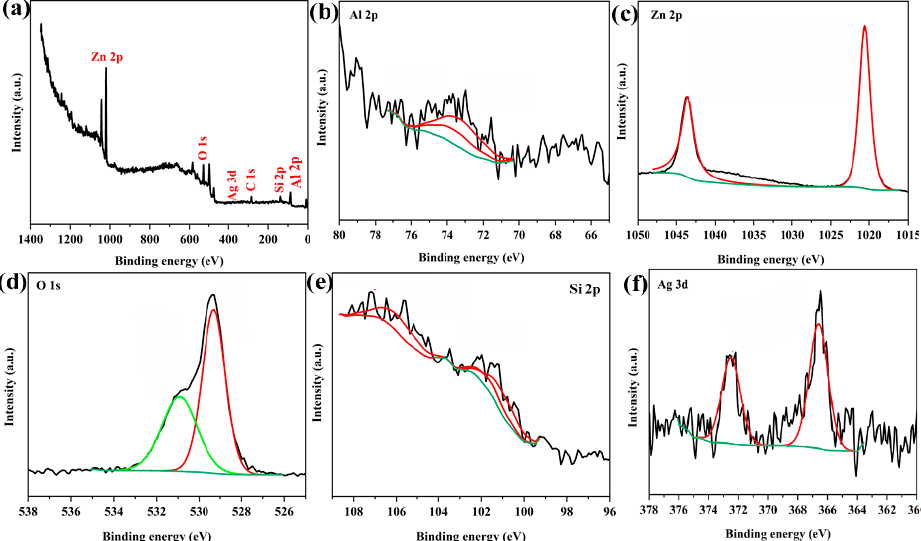
Figure 5. Spectra from XPS analysis for ( a ) Cloisite 30B/ZnO/Ag 2 O sample, and regional high-reso- lution XPS spectra of ( b ) Al 2p, ( c ) Zn 2p, ( d ) O 1s, ( e ) Si 2p, and ( f ) Ag 3d.